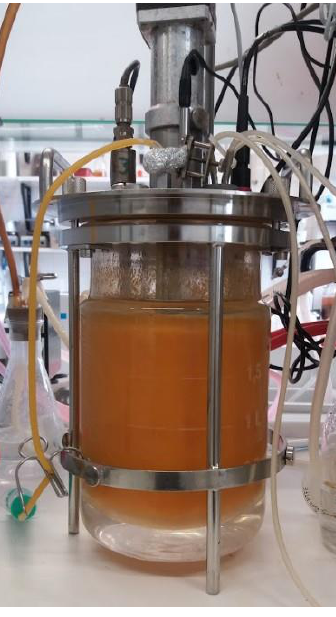
Figure 2. Phenazine production on a bioreactor cultivation of Pseudomonas chlororaphis subsp. au- rantiaca DSM 19603.